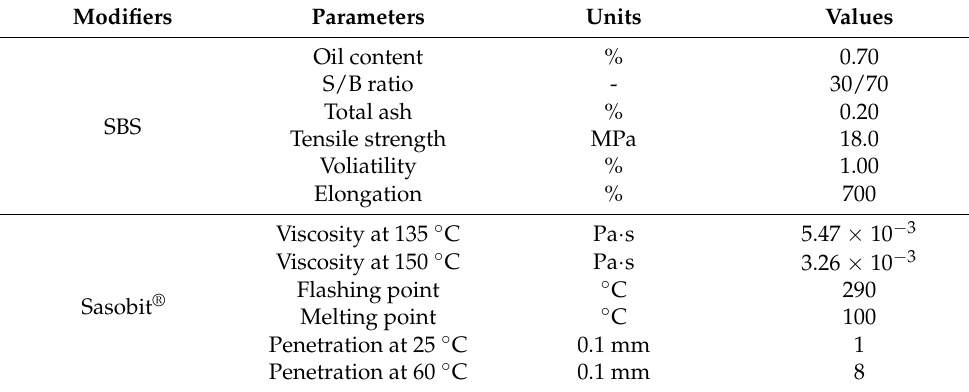
Table 2. Technical information of modifiers.